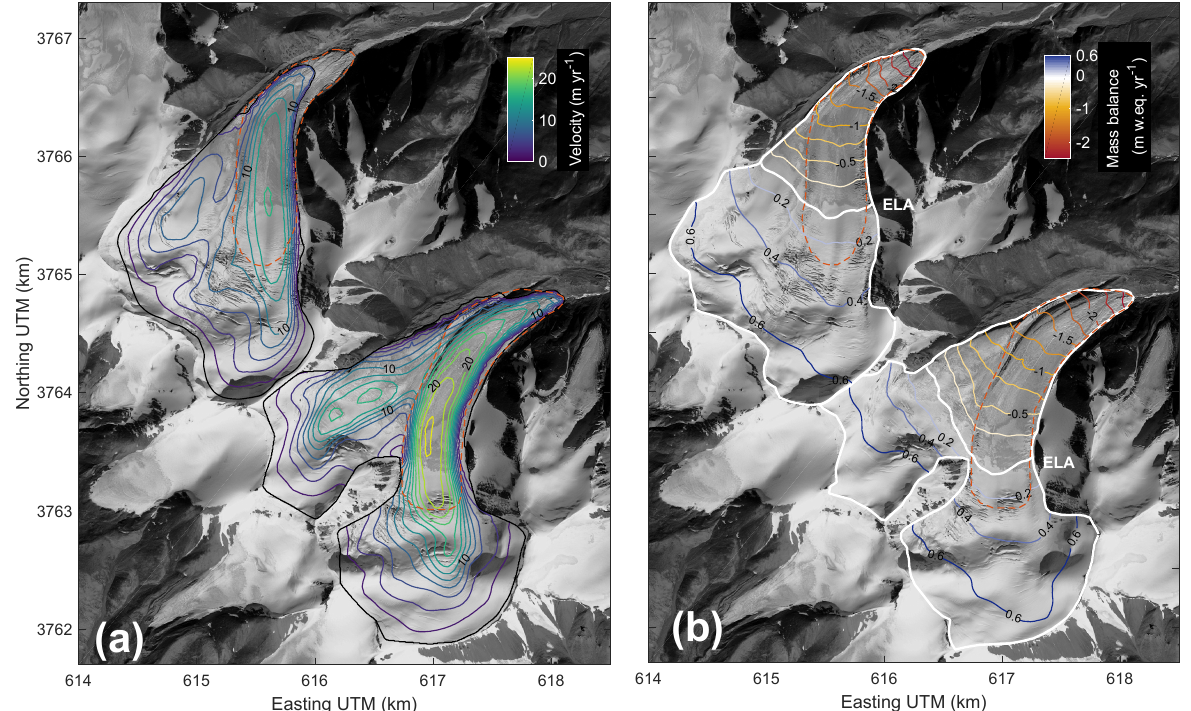
Figure 4. Modelled steady-state horizontal surface velocities (a) and surface mass balance (b) for Aru-1 and Aru-2 glaciers. The black contours in (a) are modelled steady-state glacier outlines. The white contour in (b) is the glacier outline as mapped from 2015 images. Orange dashed lines indicate the detachment